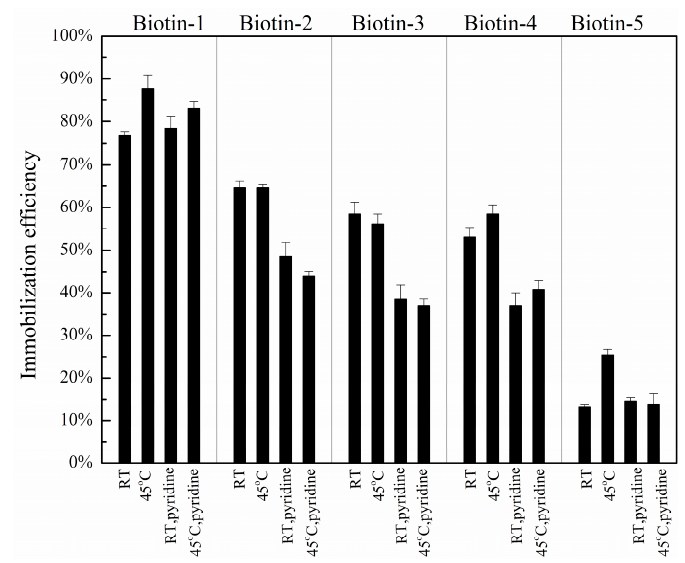
Figure 6. Immobilization efficiencies of five biotinylated compounds with different nucleophilic residues printed on a phenyl-isocyanate functionalized surface as functions of post-printing treatment.